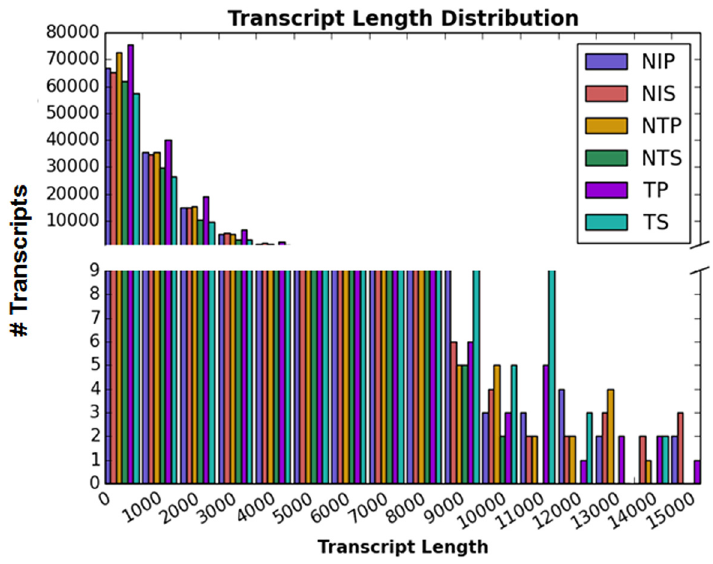
Fig 1. Lengthwise (in bp) distribution of transcripts in RNA-Seq libraries from pericarp and seed tissues of cotton with and without Aspergillus flavus infection. NIP = non-inoculated pericarp, NTP = non-toxigenic pericarp, TP = toxigenic pericarp, NIS = non-inoculated seed, NTS = non-toxigenic seed, TS = toxigenic seed.